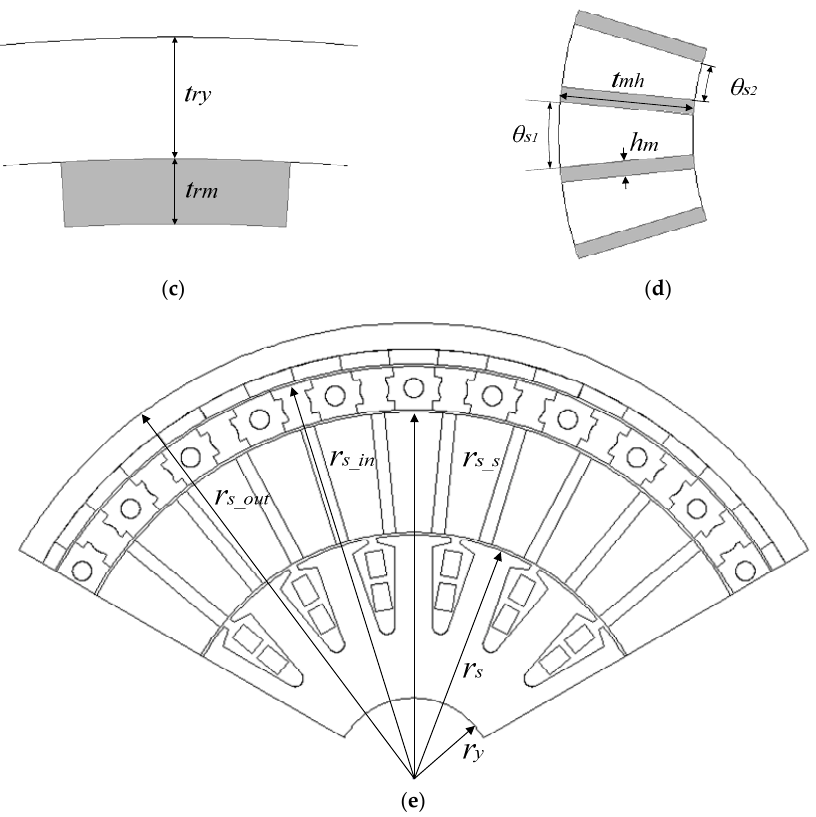
Figure 11. Geometric variables input to finite-element method: ( a ) stator; ( b ) stationary ring; ( c ) outer rotor; ( d ) inner rotor; and ( e ) radius of parameters.